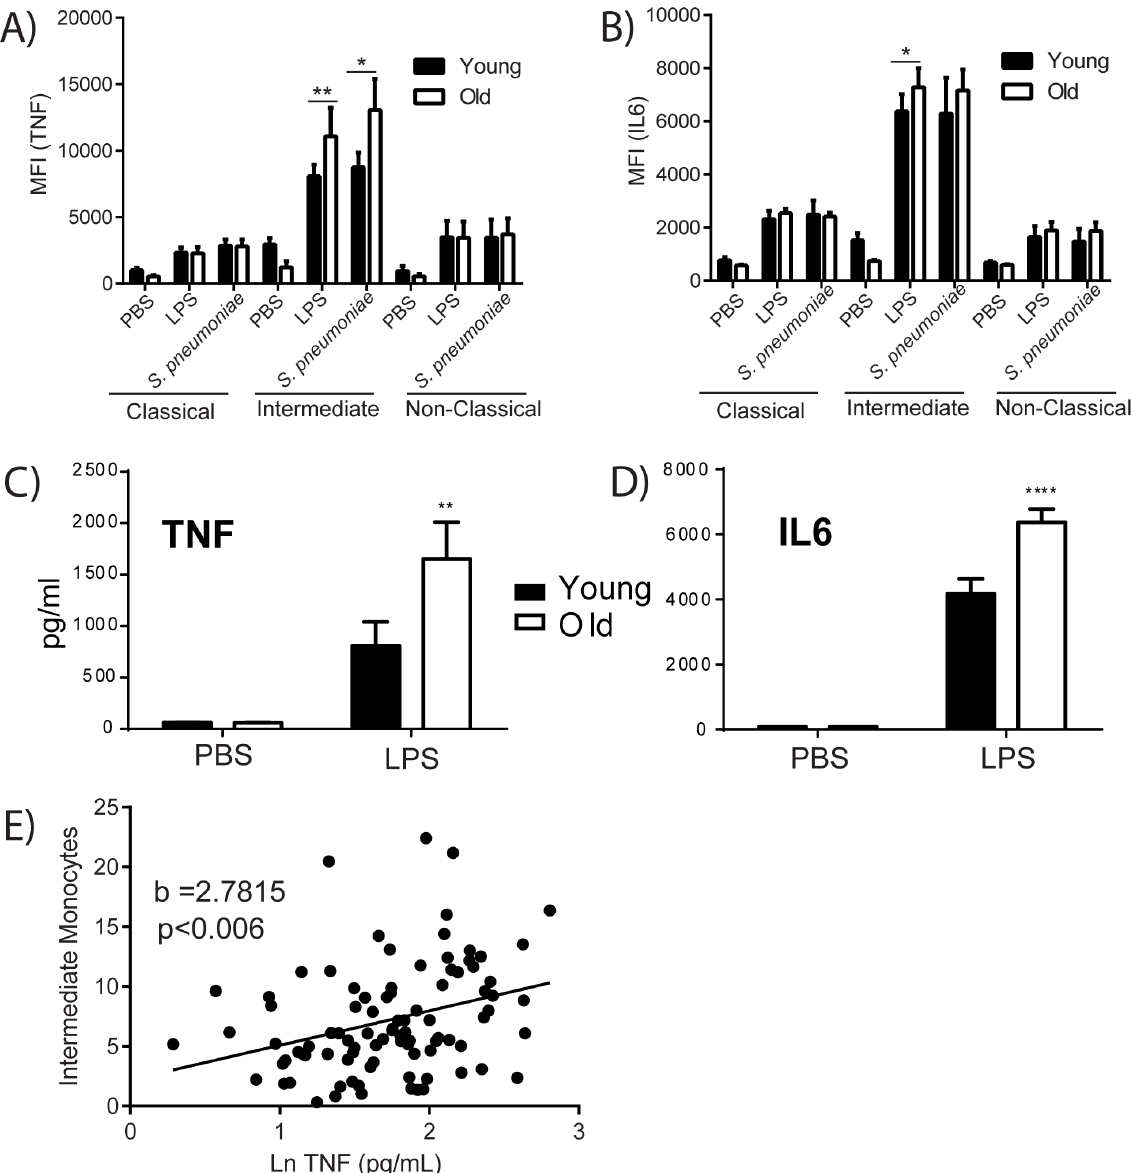
Fig 3. Human CD14 ++ CD16 + HLA-DR + (intermediate) monocytes produce more inflammatory cytokines with age. Intracellular production of TNF (A) and IL-6 (B) in classical (CD14 ++ ), intermediate (CD14 ++ CD16 + ) and non-classical (CD14 + CD16 + ) monocytes from young and elderly donors in response to LPS (50 ng/ml) and S . pneumoniae (5 x10 6 CFU) . C) The secretion of TNF and D) IL-6 for isolated CD14+ monocytes in response to LPS for young and older donors. E) The frequency of intermediate monocytes were found to have a significant, positive correlation with the levels of serum TNF ( β = 2.78, p < 0.006). (A-D) is representative of ± SEM of n = 7 young donors (26 – 52 yrs) and n = 6 older donors (63 – 70 yrs) * indicates p < 0.05, and ** indicates p < 0.05. Intermediate monocyte (CD14++CD16+HLA-DR+) count (cells per microlitre of whole blood) increases relative to serum levels of TNF in older donors (n = 94,